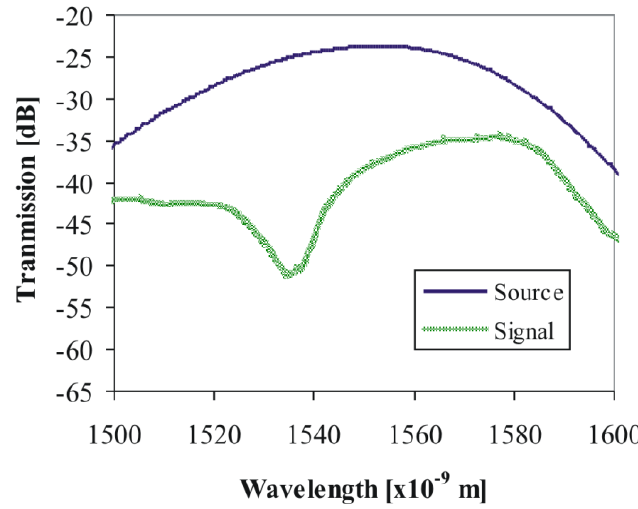
Figure 8. Transmittance spectrum of the broad band source used in the tests and an example of a signal obtained by refractive index modulating the fiber (grating manufactured under the conditions of Figure 6, with a period of about 500 μm and 50